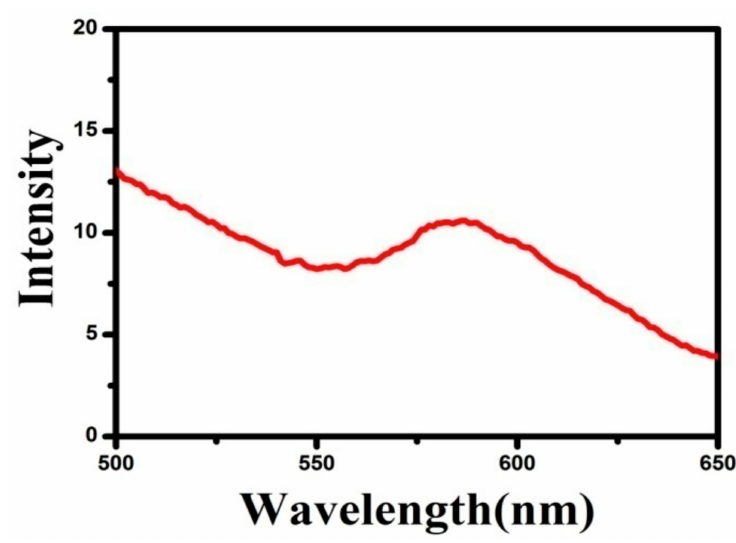
Figure 5. PL spectrum of FNH